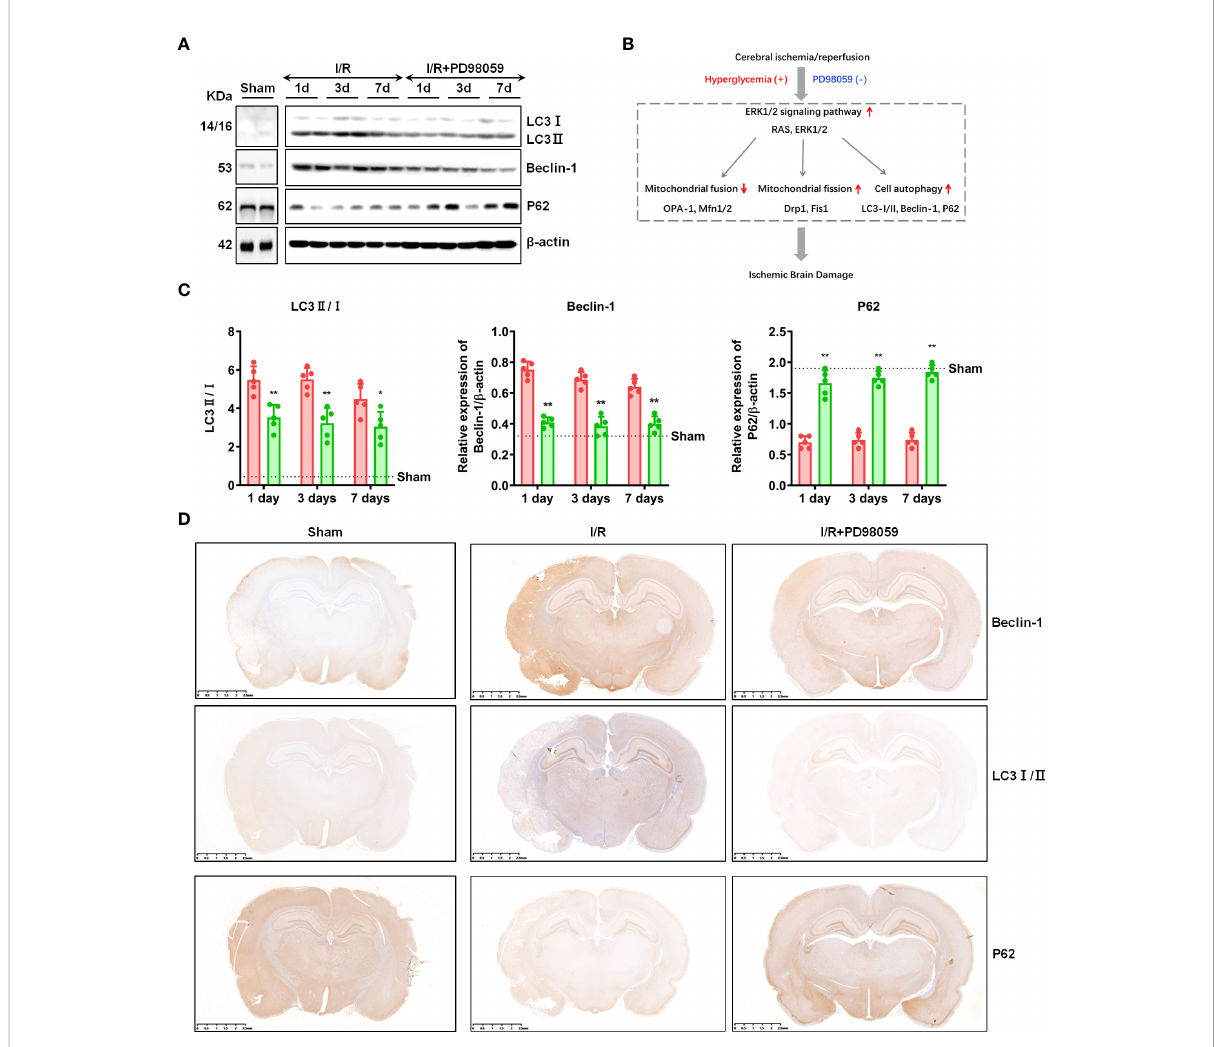
FIGURE 5 ERK1/2 inhibitor regulated cell autophagy. After I/R injury and administration of PD98059 in sham and diabetic rats, the expression of Beclin-1, LC3 I/II and P62 on the 1 st , 3 rd ,and 7 th day were detected using western blot (A) , and gray values were determined by ImageJ (B) . The expression of Beclin-1, LC3 I/II and P62 were also veri fi ed by IHC (C) . Illustration for the role of hyperglycemia in aggravating cerebral I/R-induced brain injury via ERK1/2 signaling pathway (D) . In each group, n = 5, all the results are Mean ± SD, compared with I/R *p < 0.05, **p <